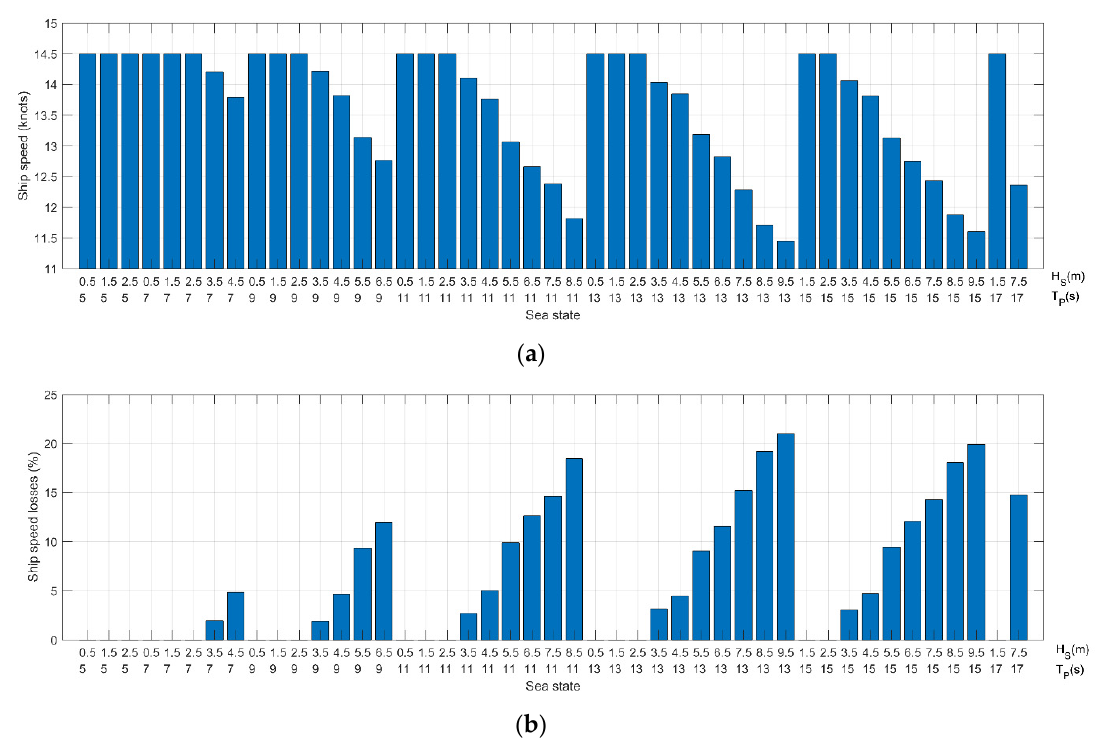
Figure 10. Variation of ship speed ( a ) and percentage of speed losses ( b ) for different sea states for 10 year old ship.